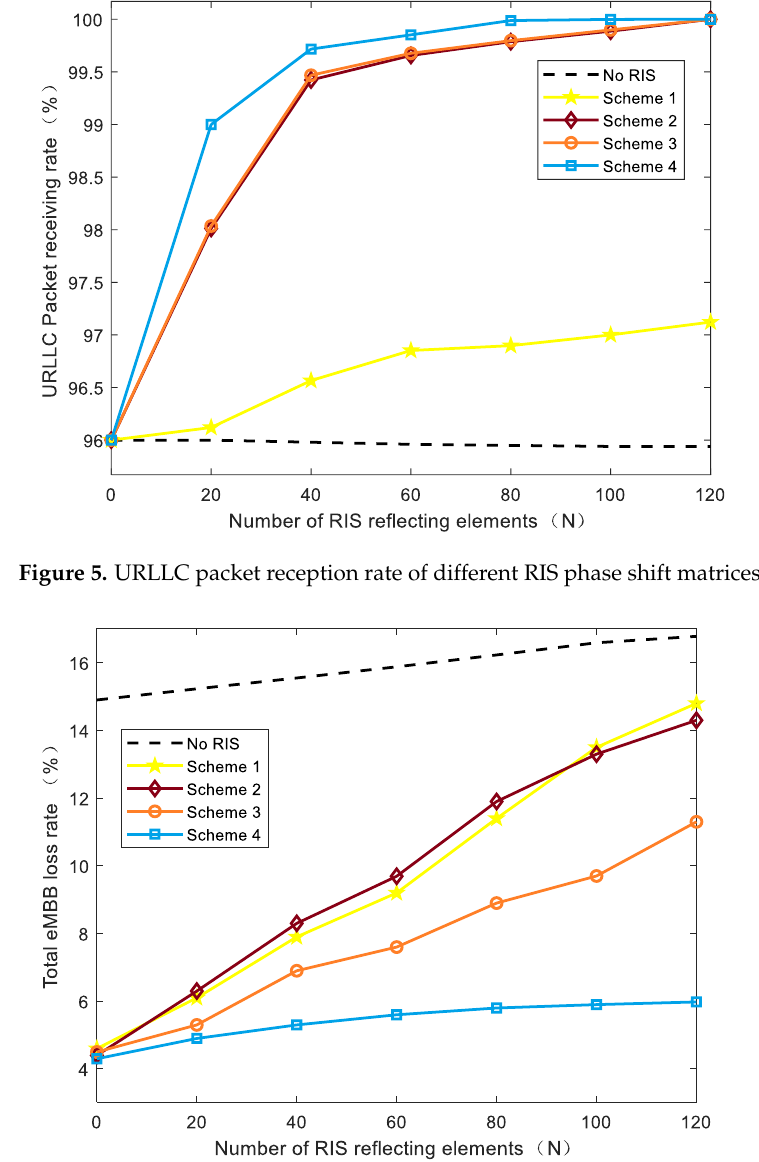
Figure 6. Total eMBB loss rate of different RIS phase shift matrices.